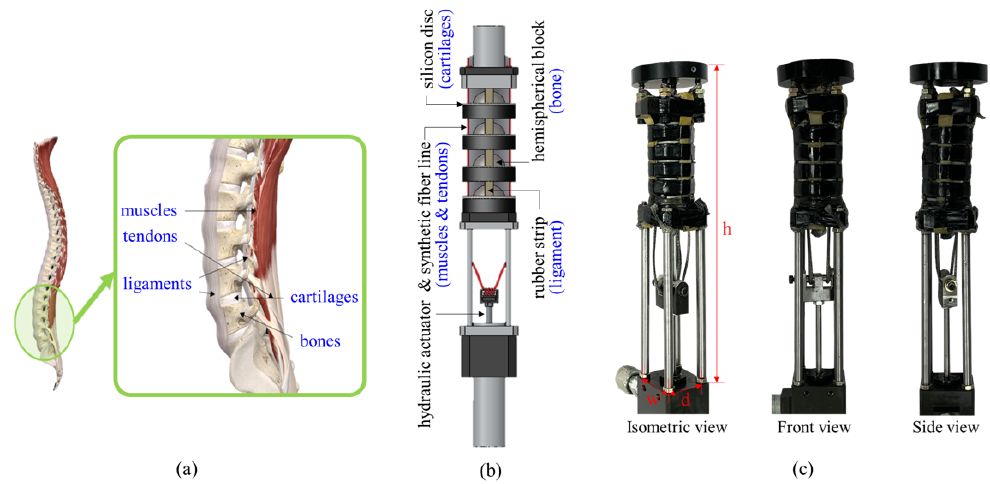
Figure 1. The SJLM design inspired by a human spine and functional correspondences: ( a ) human spine anatomy (excerpted and redrawn from https://3d4medical.com (accessed on 23 October 2021)), ( b ) SJLM components, ( c ) the fabricated SJLM: isometric view, front view, and side view.